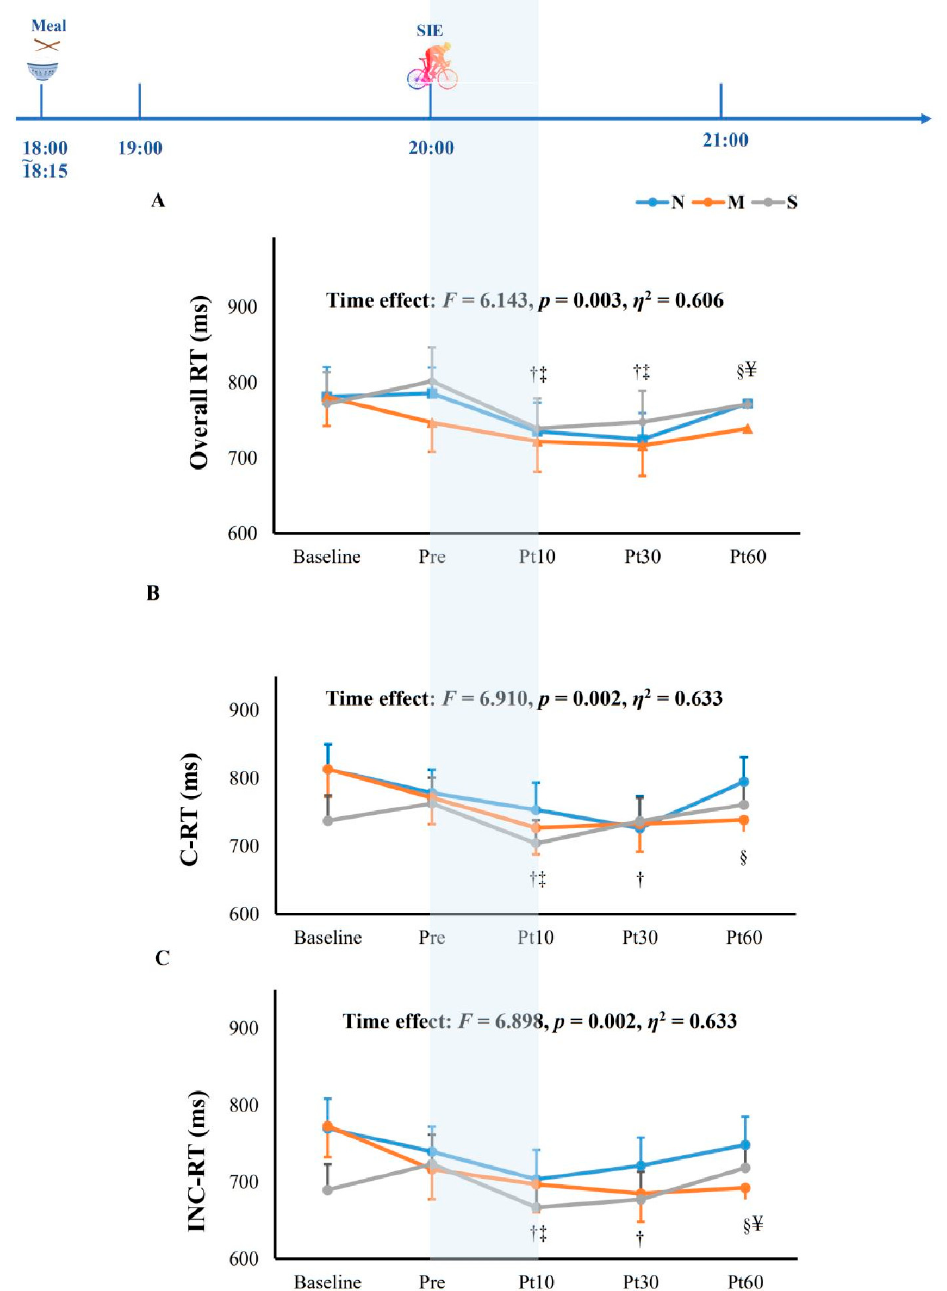
Figure 3. Overall ( A ), congruent (C-RT, B ), and incongruent reaction time (INC-RT, C ) in the Stroop test in responses to sprint interval exercise (SIE) under normoxia (20.9% O 2 ) and hypoxia (15.4%O 2 and 11.2%). The shaded part indicates oxygen condition. N: SIE in normoxia; M: SIE in moderate hypoxia; S: SIE in severe hypoxia; Pre: pre-exercise; Post 10: 10 min after exercise; Post 30: 30 min after exercise; Post 60: 60 min after exercise. † p < 0.05 vs. baseline; ‡ p < 0.05 vs. Pre; § p < 0.05 vs. Post 10; ¥ p < 0.05 vs. Post 30.